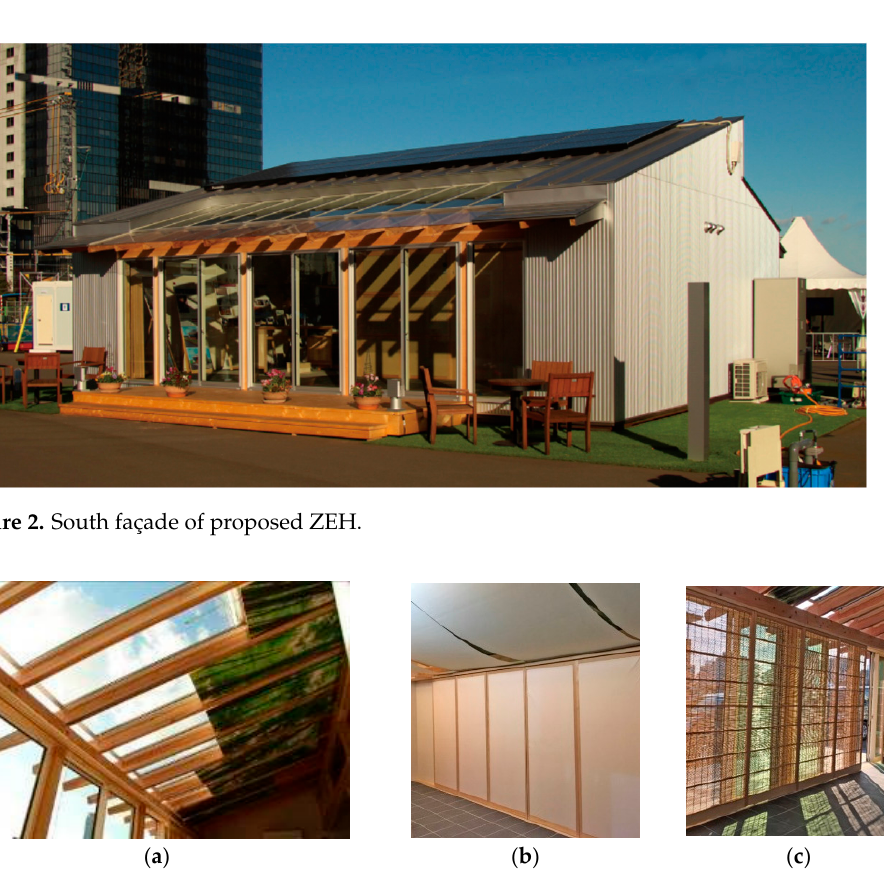
Figure 3. Photo of the fitting adjustments. ( a ) skylight and skylight fittings. ( b ) window fittings. ( c ) ventilation fittings.